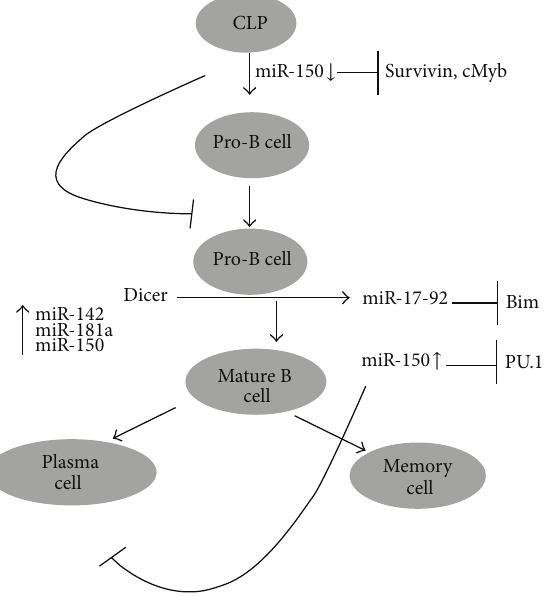
Figure 9: miRNA in B cell development and miRNA regulation of B-cell development from common lymphoid progenitor cell to produce memory and plasma